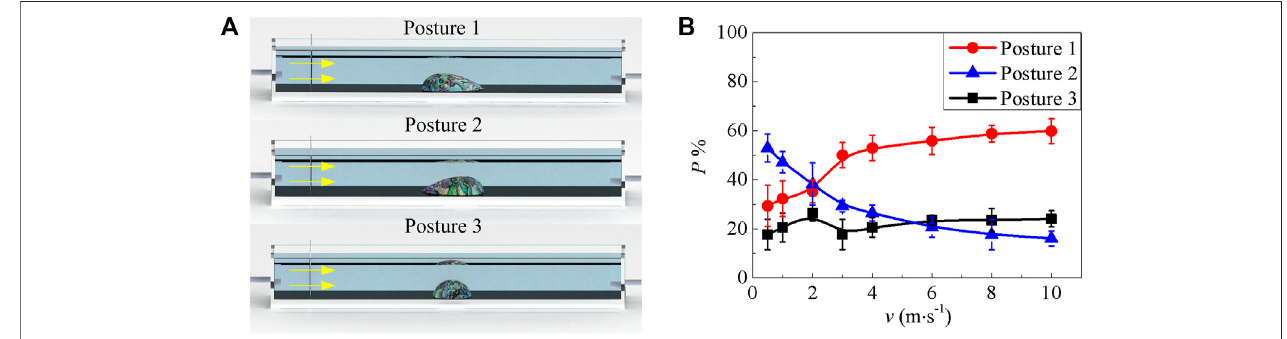
FIGURE1| Abaloneposturesinthe fl owingexperiment (A) Abalonewiththreepostures,i.e.itusesthetail, headand sidetocomplywithwater(the yellowarrow is the direction of the water fl ow) (B) Probabilities of three postures under various fl ow velocities. Error bar is the standard error of fi ve repeated scouring experiments.